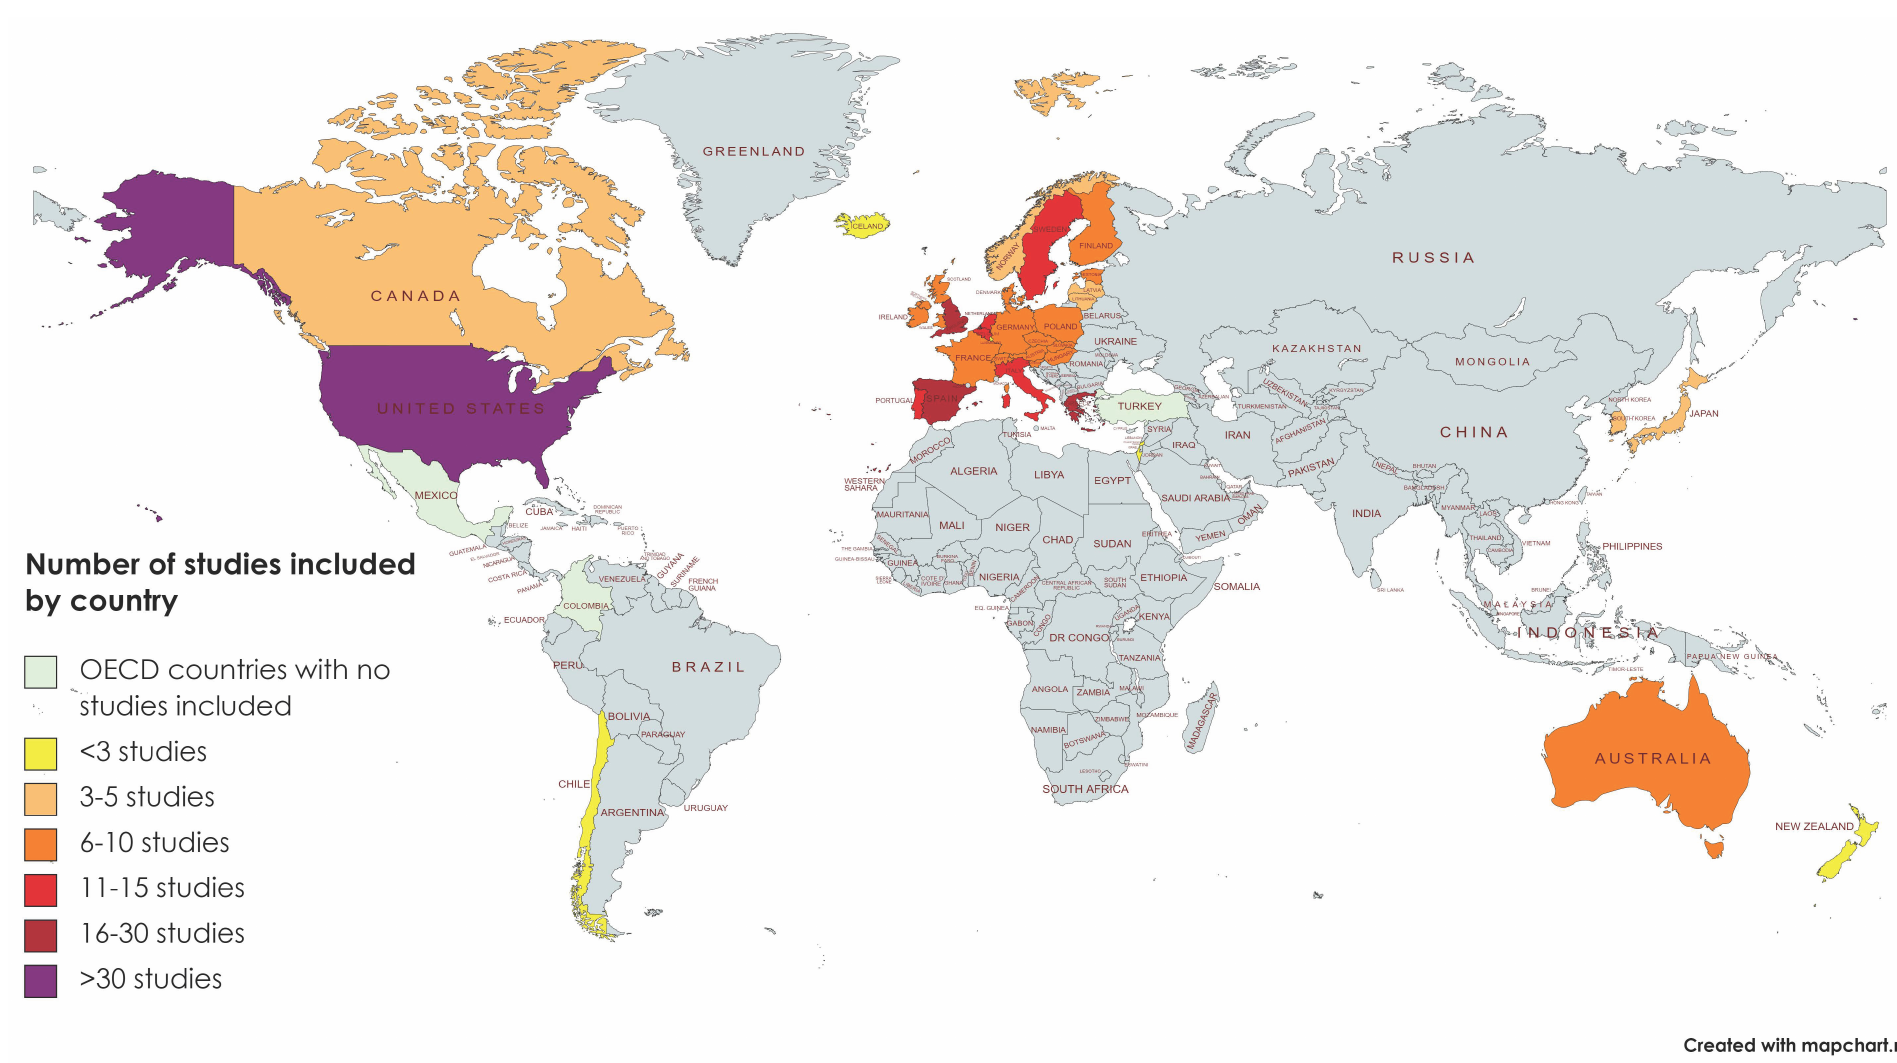
Figure 2. Geographical distribution of included